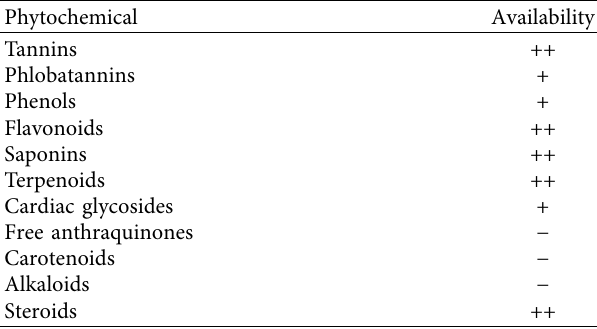
Table 1: Qualitative phytochemical analysis of ECE.